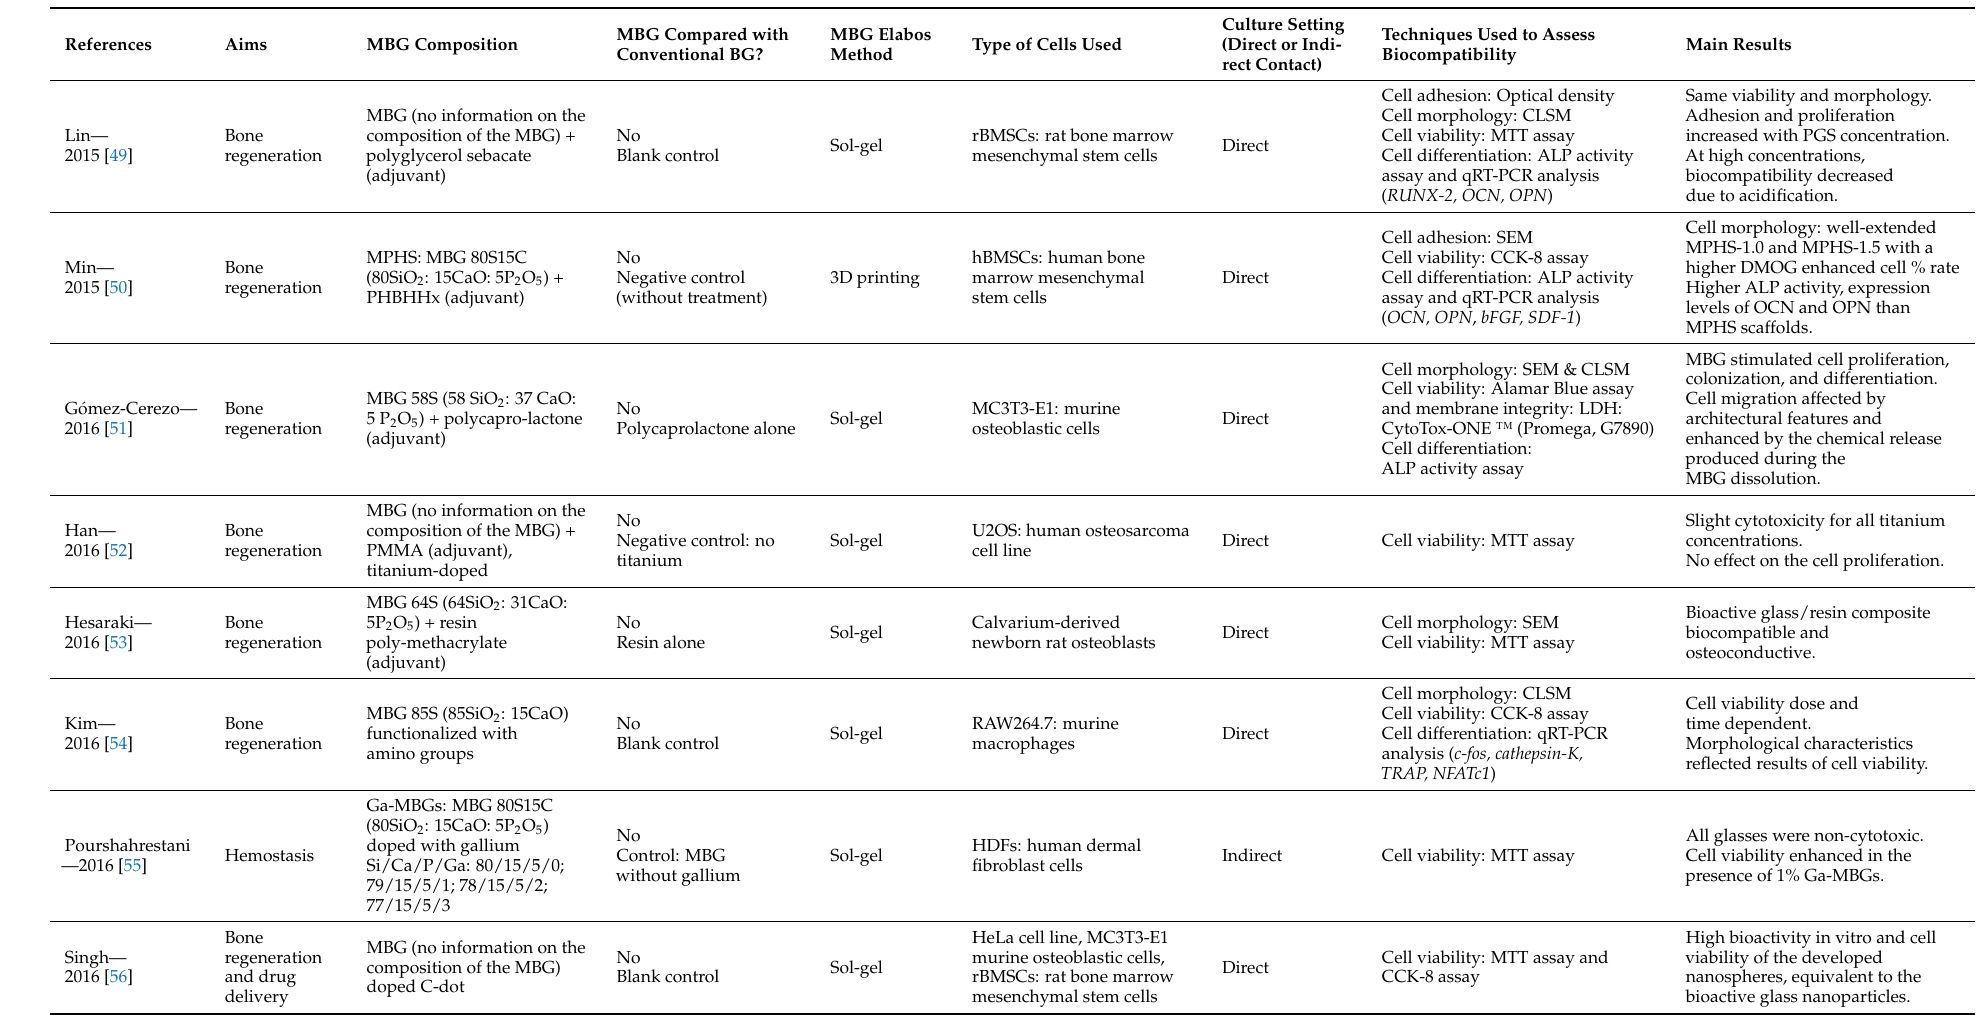
Table 3. Articles included and details of each